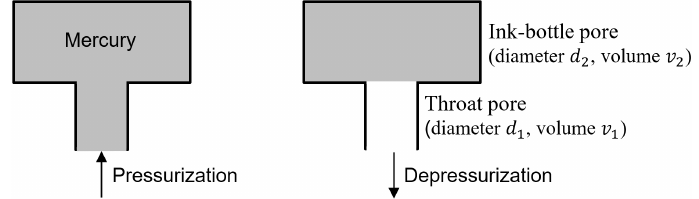
Figure 2. Mercury pressurization-depressurization hysteresis in a pore system with a throat pore connecting an ink-bottle pore.